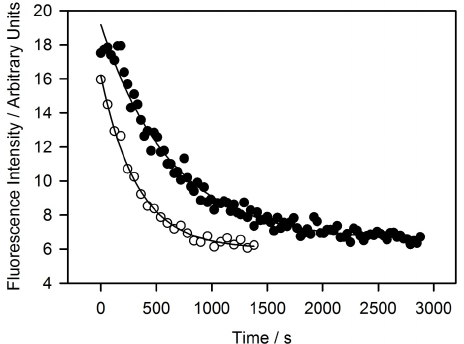
Fig. 2. Decay in fluorescence emission intensity at the surface of Figure 2 2.6 × 10 − 7 M pyrene in deionized water (337nm excitation; 392nm emission) upon exposure to ∼ 6 × 10 15 moleculescm − 3 ozone. The solid circles show the dark reaction while the hollow circles show the light reaction. All experiments were performed at room temper- ature and atmospheric pressure.